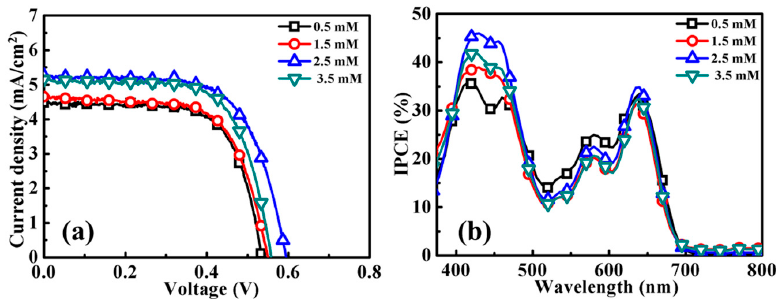
Figure 3. ( a ) J–V curves and ( b ) Incident-photon-to-current efficiency (IPCE) spectra of YD2-o-C8-TBA- sensitized ZnO DSSCs with photoanodes prepared using ethanol solutions of 0.1 mM YD2-o-C8-TBA with various concentrations of CDCA at RT for 15 h.